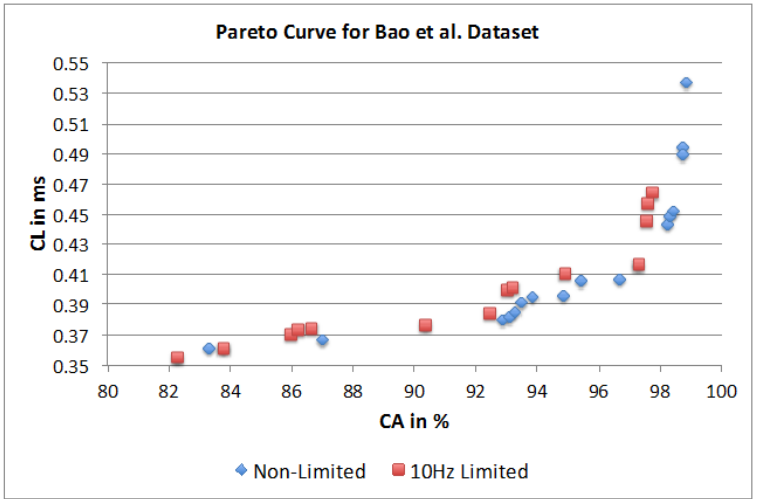
Figure 22. Dominant points on the Pareto